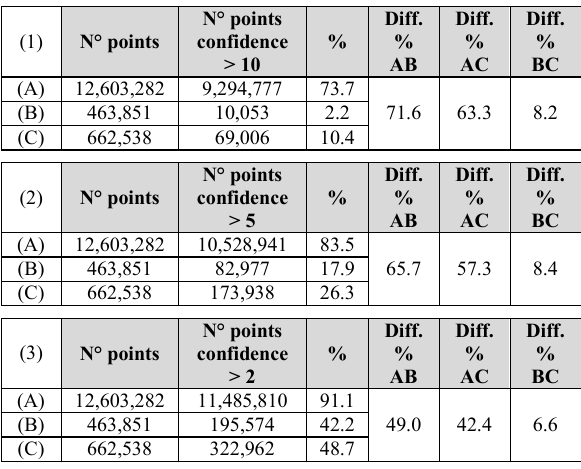
Table 9 . Parabolic arch of Morano sul Po point cloud analysis. N° of points with confidence greater than 10 (1), 5 (2) and 2 (3) for: (A) visible dataset, (B) thermal dataset (Workflow 1) (C) thermal dataset (Workflow